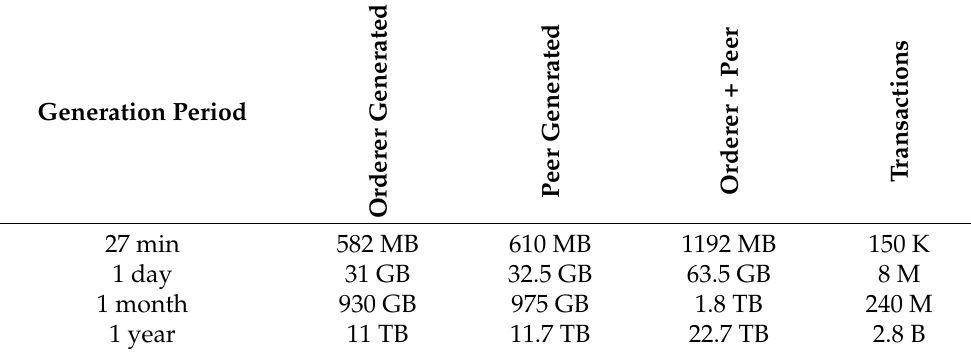
Table 9. Data generation and transaction estimates based on the successful Phase 2 round.